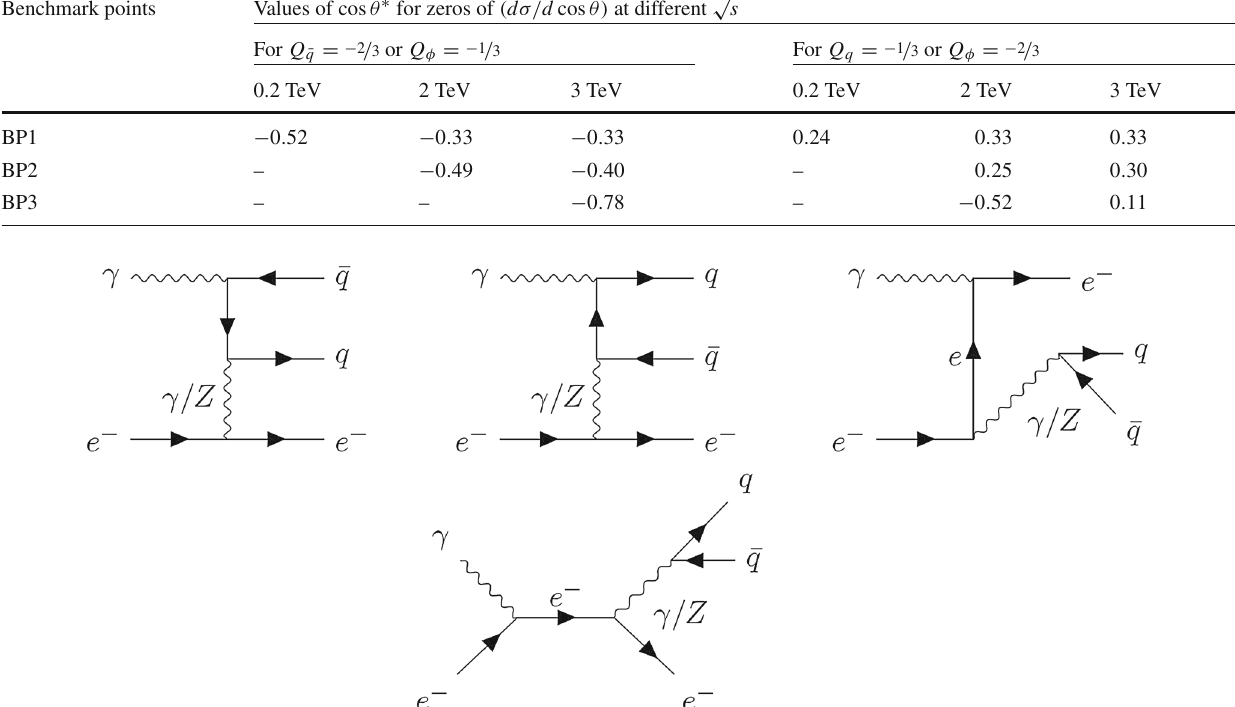
Fig. 4 Feynman diagrams for the SM background of the process e − γ → e − + 2